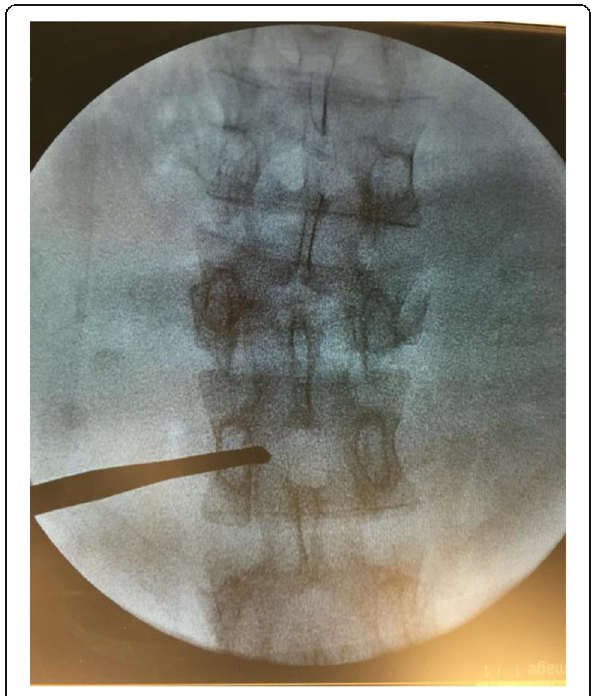
Fig. 5 Pedicles were tapped with a tap cannula from the lateral pedicular margin until it reached the medial margin of the pedicle in AP